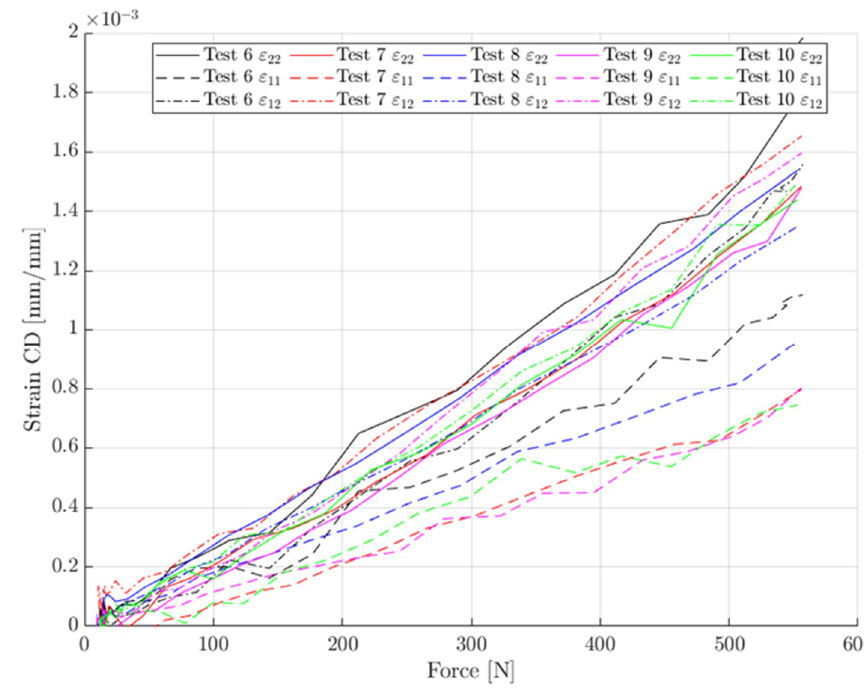
Figure 13. The consistency of the data from tests 6–10.